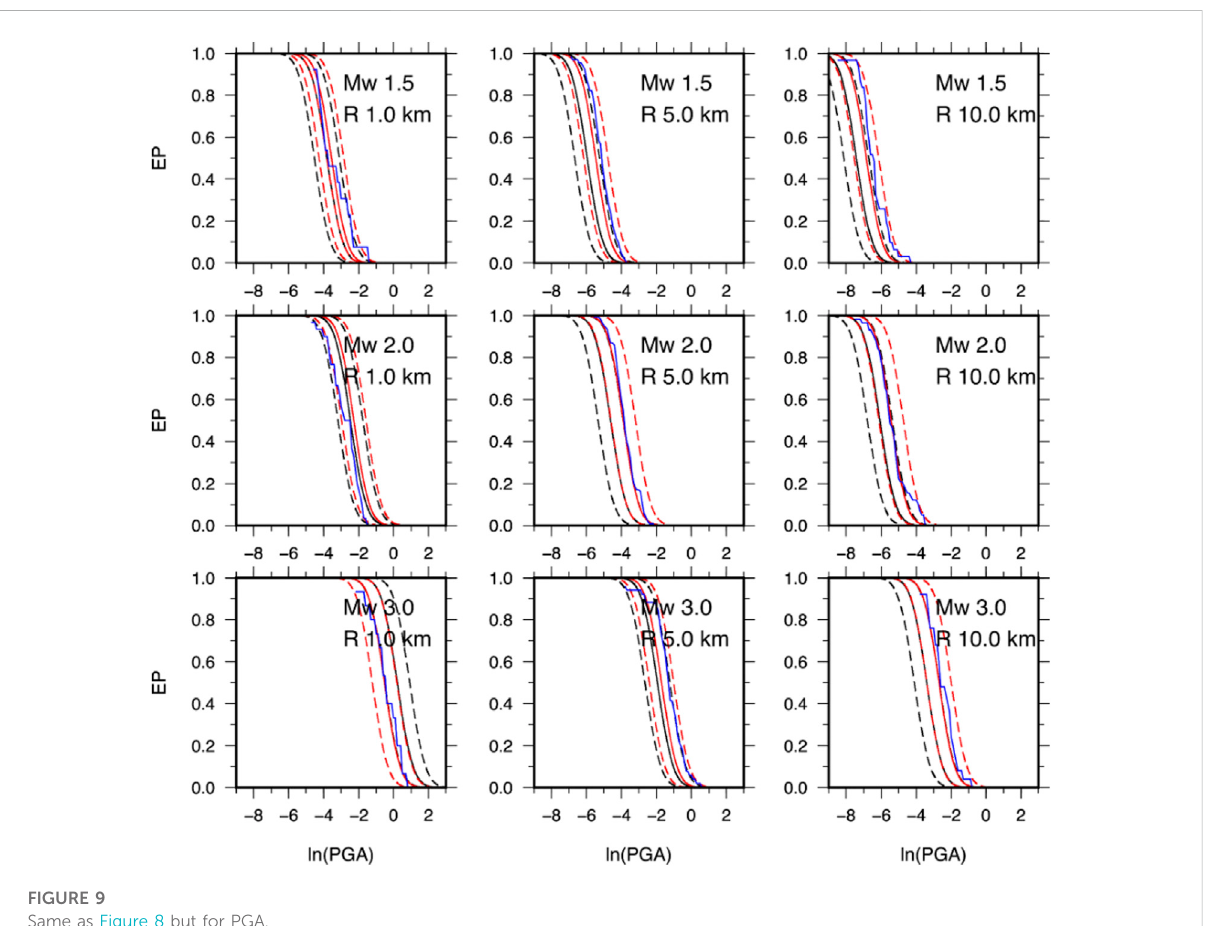
FIGURE 9 Same as Figure 8 but for